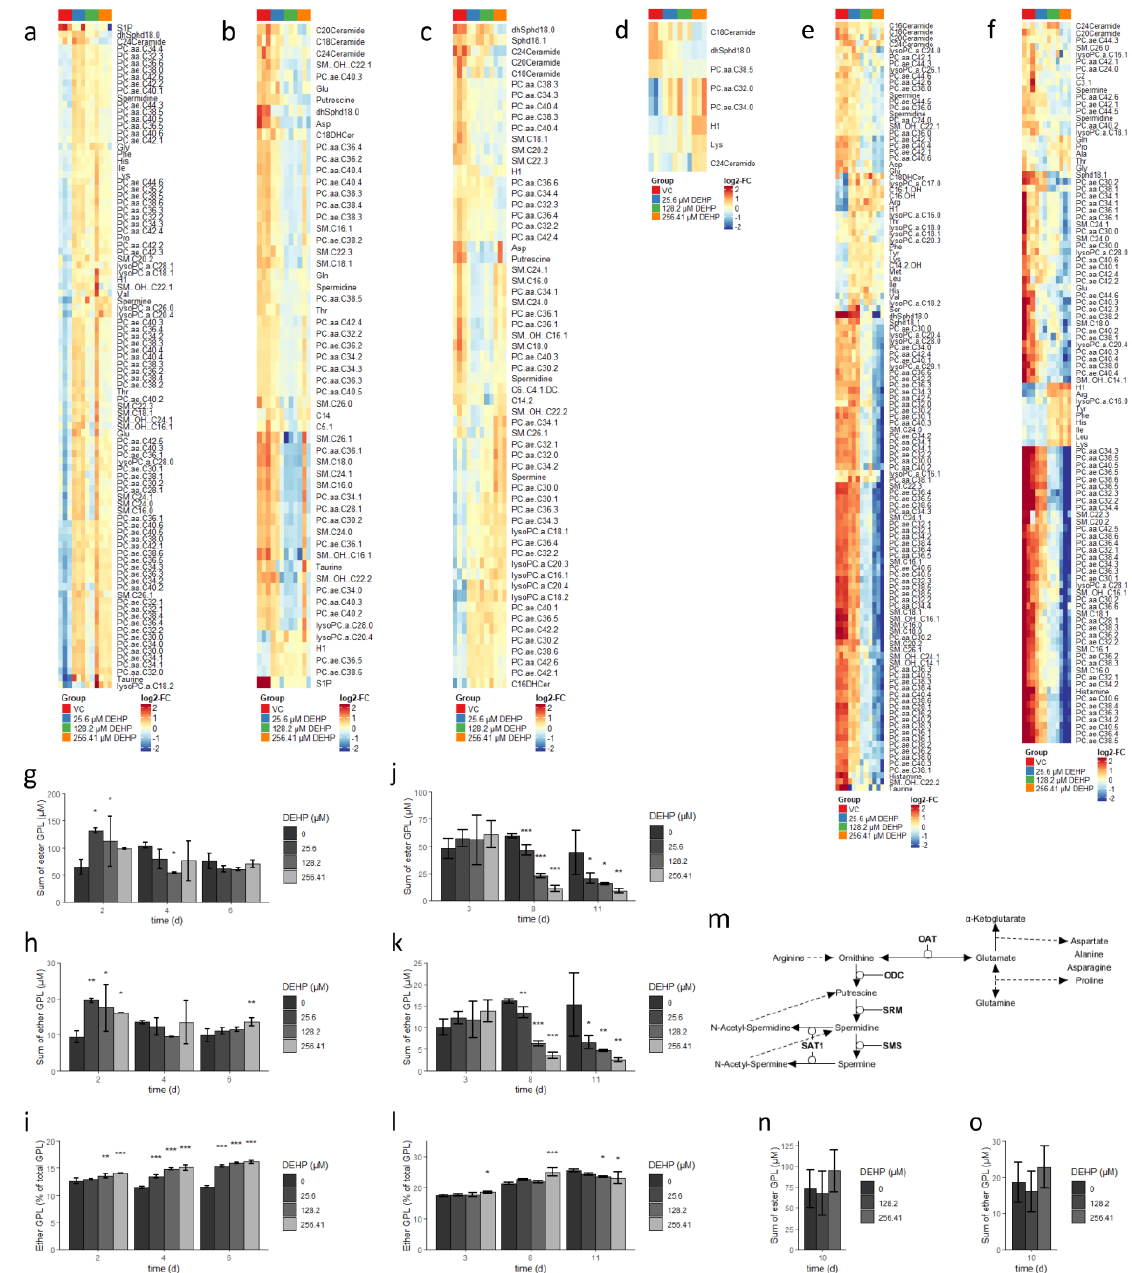
Figure 2. DEHP alters the lipidome and suppresses glycolysis, glutaminolysis, and polyamine synthesis in erythrocytes and dendritic cells. ( a – c ) Erythrocyte metabolites altered (FDR-significant) after 2 days ( a ), 4 days ( b ), and 6 days ( c ) in culture with increasing concentrations of DEHP ( d – f ) Dendritic cell metabolites (FDR-significant) after 3 days ( d ), 8 days ( e ), and 11 days ( f ) in culture with increasing concentrations of DEHP. ( g ) Total ester glycerophospholipids (GPL) concentration in erythroid cultures treated with increasing concentrations of DEHP. ( h ) Total ether GPL concentration in erythroid cultures treated with increasing concentrations of DEHP. ( i ) Percent ether GPL content in erythroid cultures treated with increasing concentrations of DEHP. ( j ) Total ester GPL concentration in dendritic cell cultures treated with increasing concentrations of DEHP. ( k ) Total ether GPL concentration in dendritic cell cultures treated with increasing concentrations of DEHP. ( l ) Percent ether GPL content in dendritic cell cultures treated with increasing concentrations of DEHP. ( m ) Model depicting the interconnections between altered metabolites associated with glutaminolysis and polyamine synthesis. ( n ) Total ester GPL content in neutrophil cultures treated with increasing concentrations of DEHP. ( o ) Total ether GPL content in neutrophil cultures treated with increasing concentrations of DEHP. Data are presented as mean ± SEM. Statistical significance was determined by one-way ANOVA (* p < 0.05; ** p < 0.01; *** p <